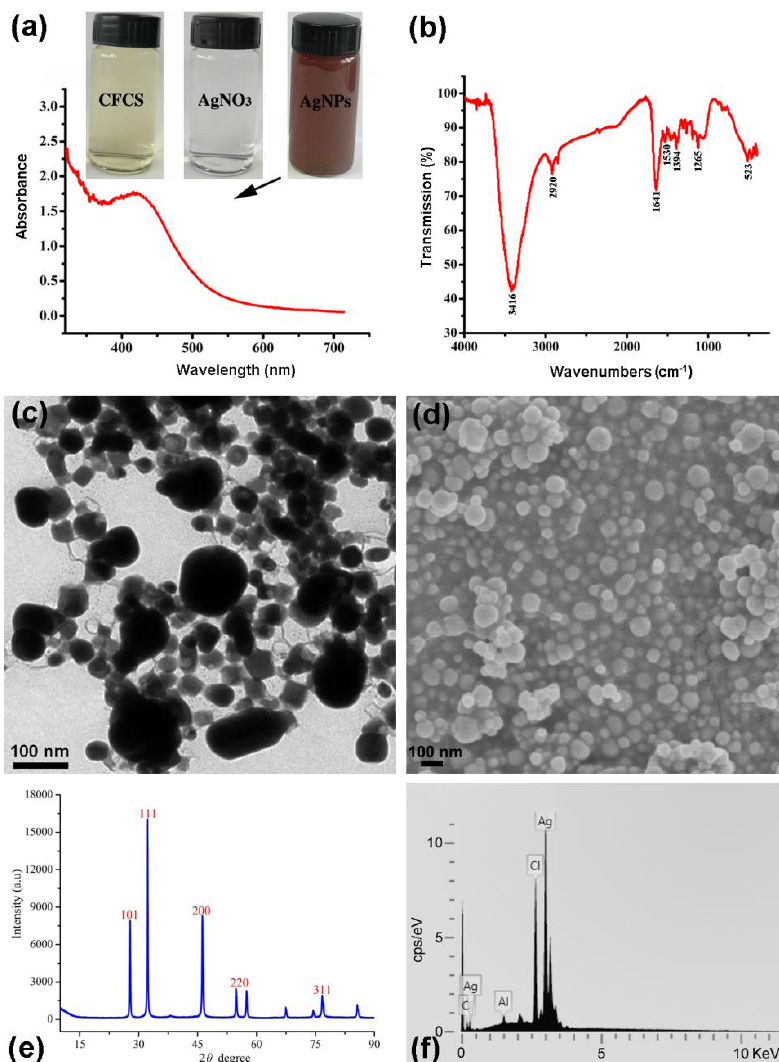
Figure 1. Characterization of silver nanoparticles (AgNPs) synthesized with cell-free culture filtrate (CFCS) of Pseudomonas rhodesiae . ( a ) UV–Visible absorption spectrum of the dark brown AgNP solution, which was formed by mixture of light yellow CFCS and colorless AgNO 3 solution. AgNPs display a clear surface plasmon resonance peak at 420-430 nm. ( b ) Fourier transform infrared spectrum showing functional groups responsible for the synthesis and stabilization of AgNPs. ( c ) Transmission electron micrograph showing AgNPs in spherical forms about 20-100 nm in diameter. ( d ) Scanning electron micrograph showing AgNPs in spherical forms about 20-100 nm in diameter. ( e ) X-ray di ff raction spectrum showing the nanoscale size and crystalline nature of the AgNPs. ( f ) Energy dispersive spectrum showing the predominance of Ag element in the AgNP product.